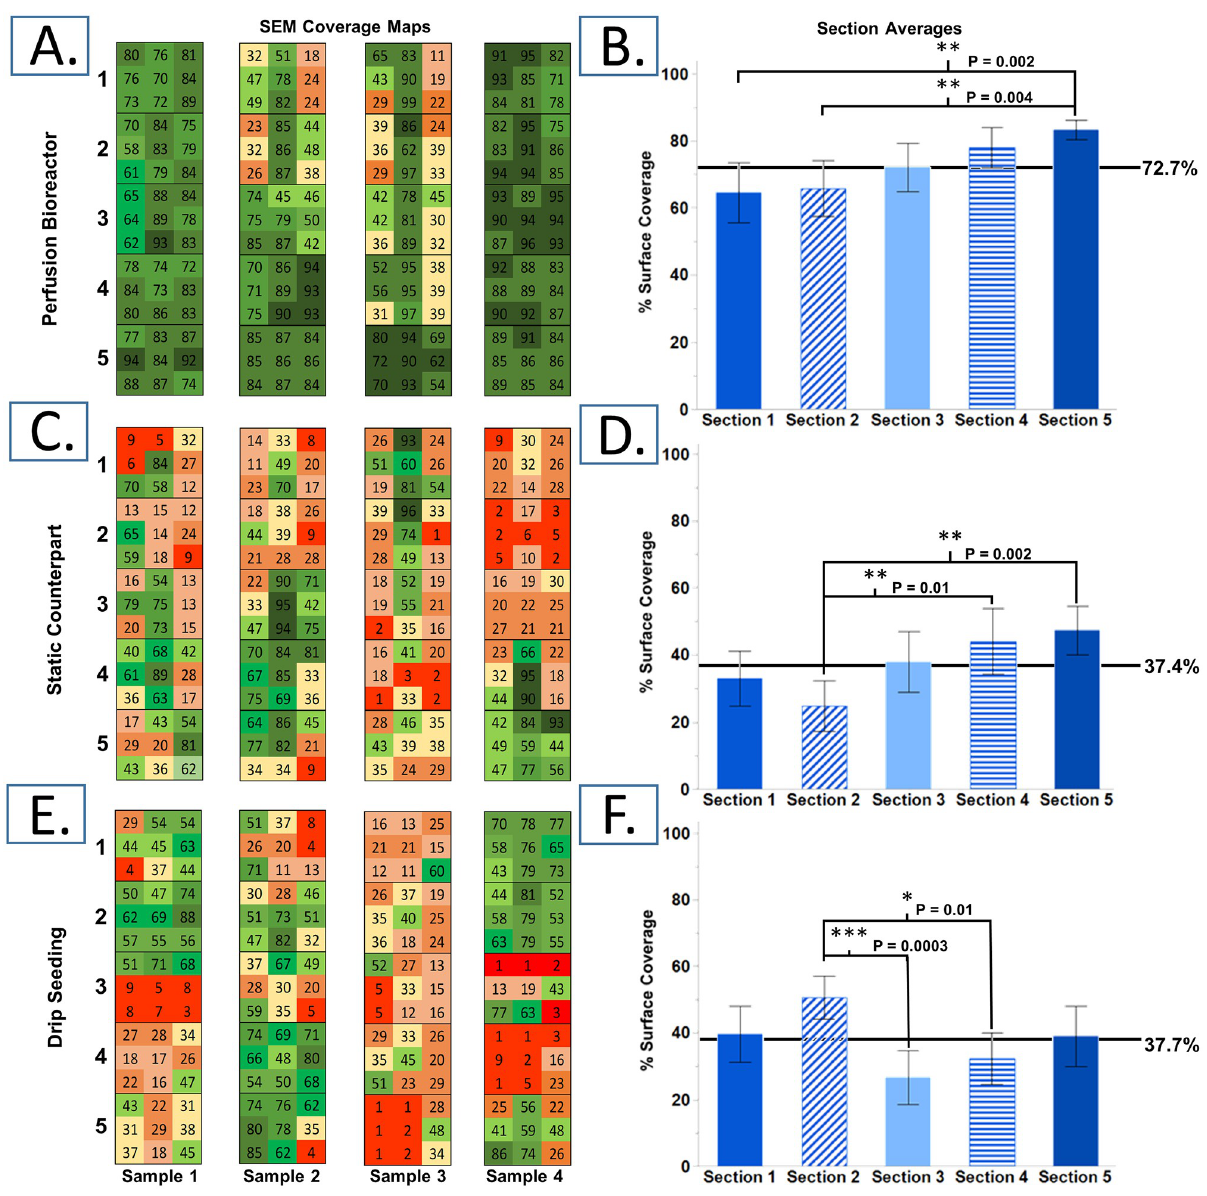
Fig 9. Quantitative analysis of surface coverage. Color map of surface coverage and section averages respectively for (A,B) perfusion bioreactor seeding, (C,D) static counterpart seeding, and (E,F) drip seeding (n = 36; mean with 95% confidence intervals).